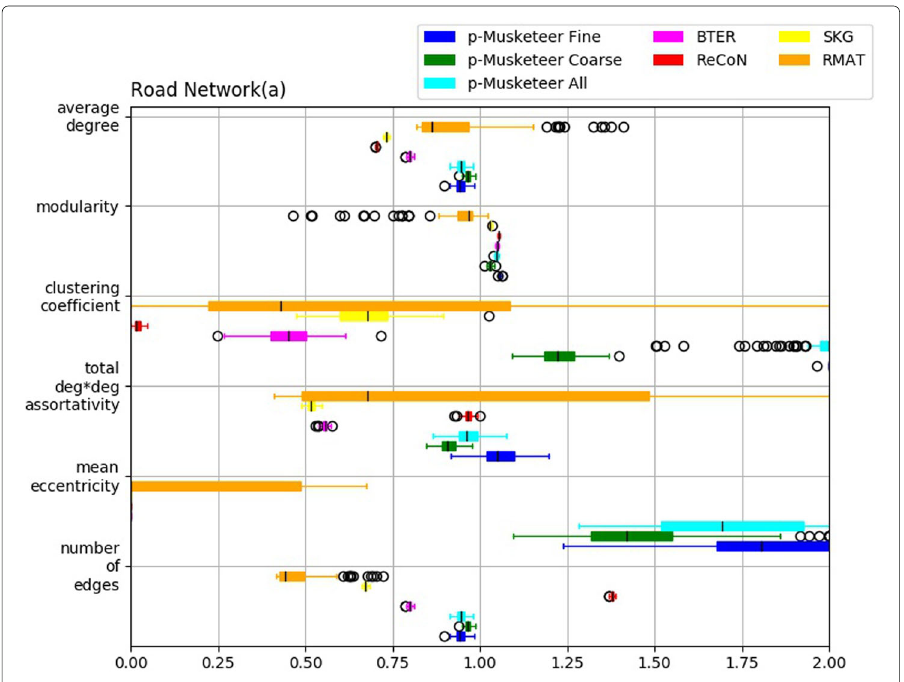
Fig. 8 Computational results on performance of planar Musketeer on road network from roadNet-TX with 2001 nodes and 2957 edges for clustering coefficient, number of edges, mean eccentricity, total degree *degree assortativity, modularity and average degree